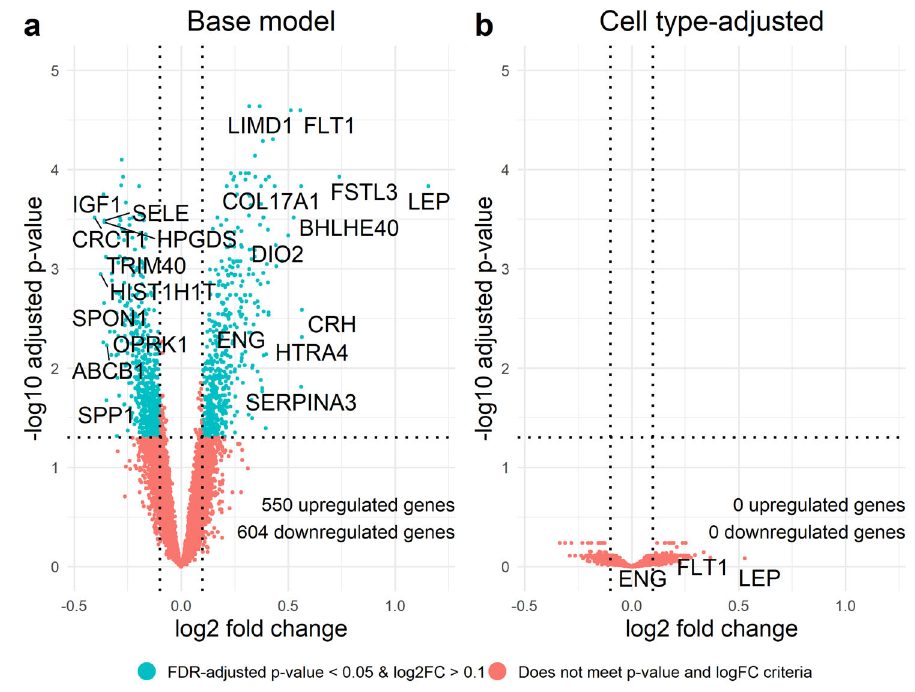
Fig. 4 Preeclampsia case – control differential expression analysis. Volcano plots comparing differentially expressed genes in samples from 153 preeclampsia cases versus 173 healthy controls across two models: a the base model adjusted for covariates fetal sex, study source, and gestational age and b the model adjusted for fetal sex, study source, and gestational age and additionally adjusted for the fi rst fi ve principal components of estimated cell type proportions. Dotted line represents a false discovery rate-adjusted q value of 0.05. FLT1 , LEP , and ENG are labeled as genes of interest in